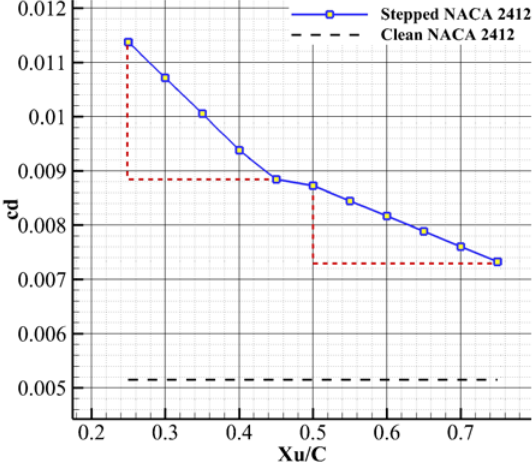
Figure 12. The variation of the drag coefficient at different step locations ( Re = 5.9 × 10 6 and α = 2.5 ◦